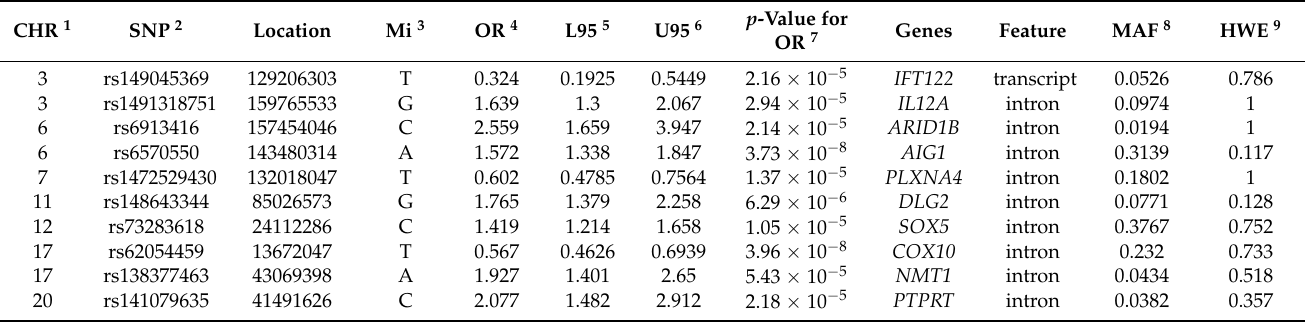
Table 3. The characteristics of the ten genetic variants of genes related to osteoarthritis in adults using the generalized multifactor dimensionality reduction analysis.